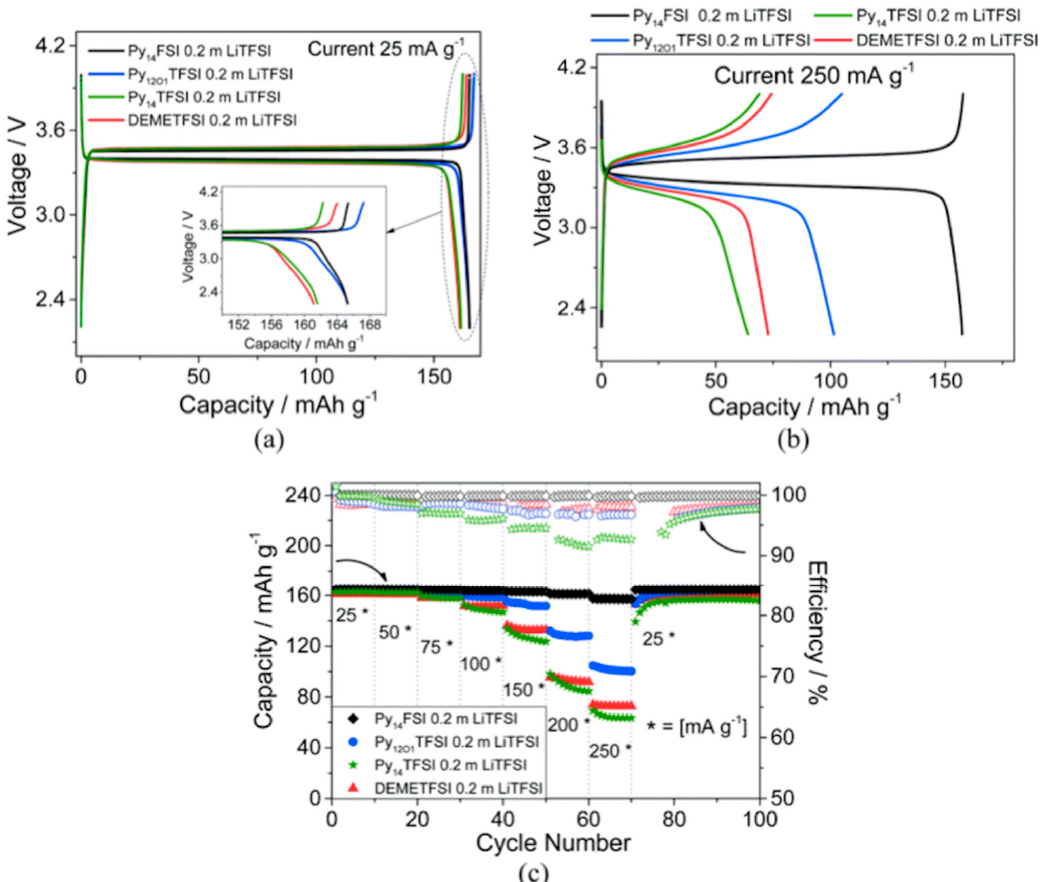
Figure 9. Li | IL | LFP cells galvanostatically cycled at ( a ) 25 mA g − 1 (0.12 mA cm − 2 ), with inset reporting the magnification of the final part of the curves, and ( b ) 250 mA g − 1 (1.2 mA cm − 2 ). ( c ) Cycling trend and columbic e ffi ciency of the Li / IL / LFP cells at increasing currents. Voltage cut-o ff s were 2.2 and 4 V. Pyr 14 TFSI–LiTFSI (green), Pyr 14 FSI–LiTFSI (black), Pyr 1(2o1) TFSI–LiTFSI (blue) and DEME-TFSI–LiTFSI (red). All measurements were performed at 40 ◦ C. Reprinted with permission from Elia et al.